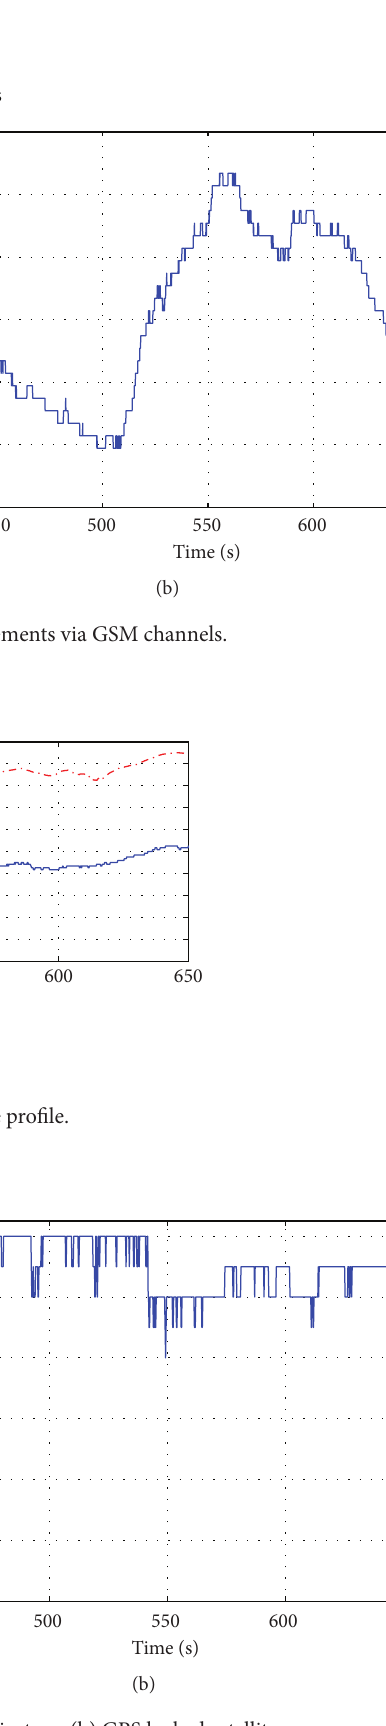
Figure 20: Flight test GPS measurements: (a) GPS trajectory, (b) GPS locked